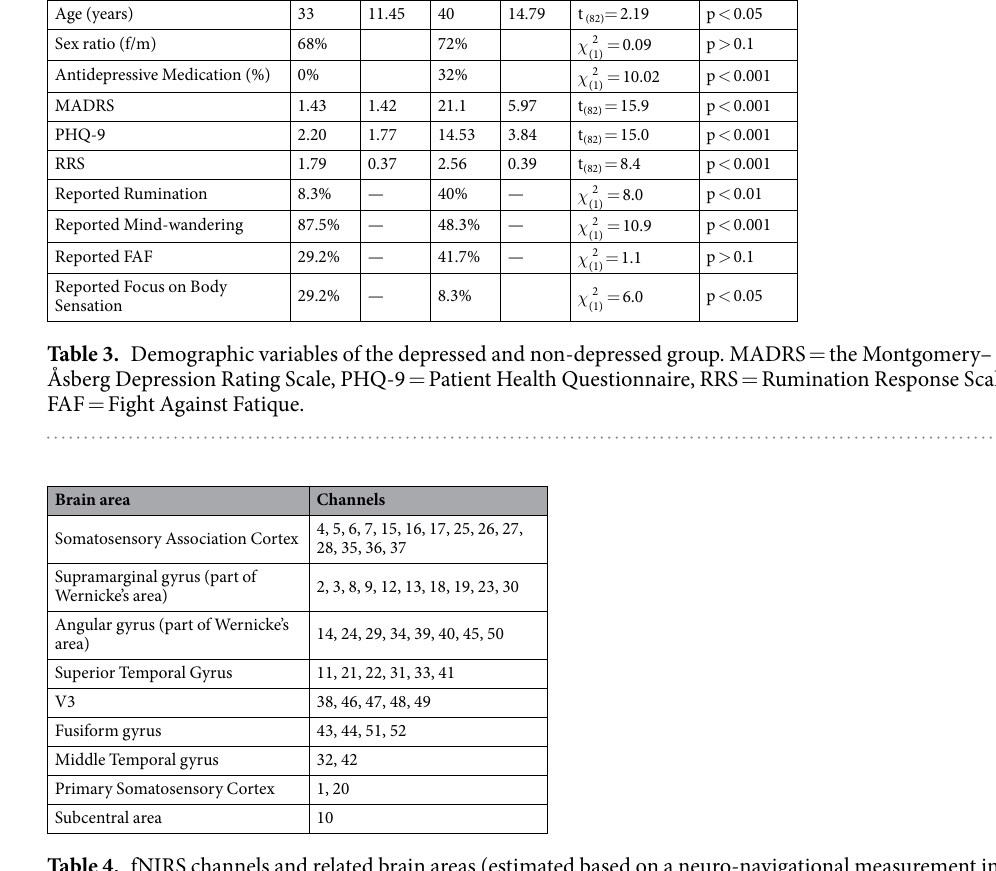
Table 4. fNIRS channels and related brain areas (estimated based on a neuro-navigational measurement in an exemplary